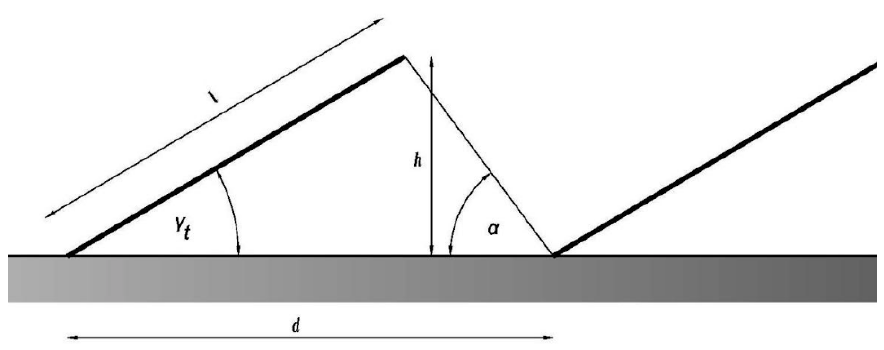
Figure 6. The calculation of the minimum distance between the neighbouring arrays of PV panels [16].